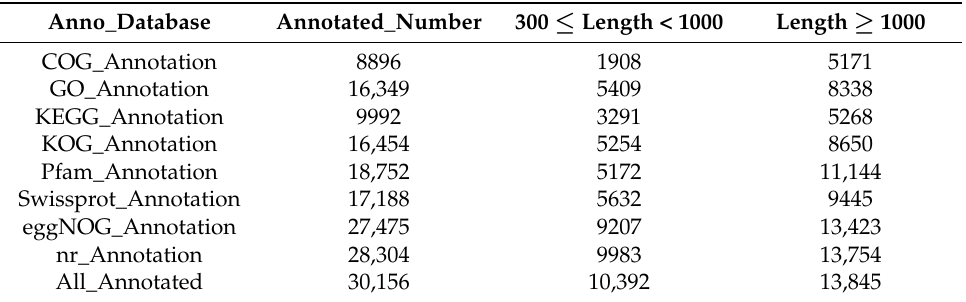
Table 1. Summary of functional annotation for N. pseudonarcissus unigenes in public databases.